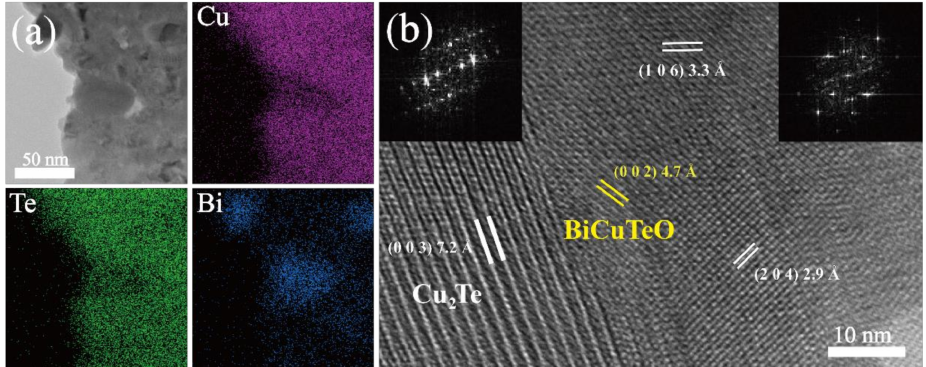
Figure 3. ( a ) TEM and EDS for (Cu 2 Te) 0.9 -(BiCuTeO) 0.1 . ( b ) HRTEM for (Cu 2 Te) 0.9 -(BiCuTeO) 0.1 . The insets are the corresponding fast Fourier transform (FFT) patterns for the areas marked in Figure